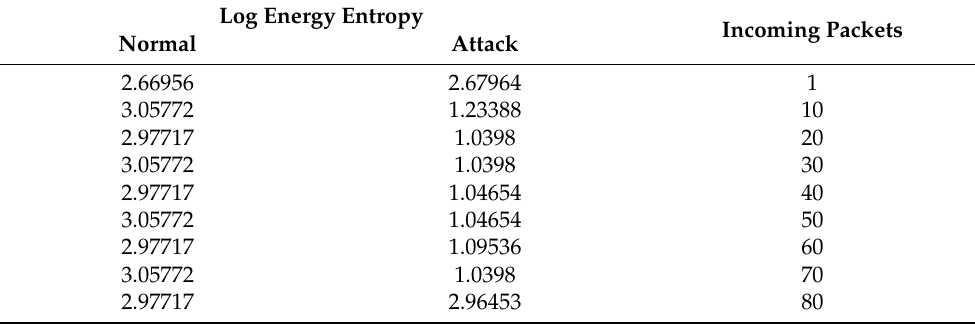
Table 3. Log Energy Entropy values.